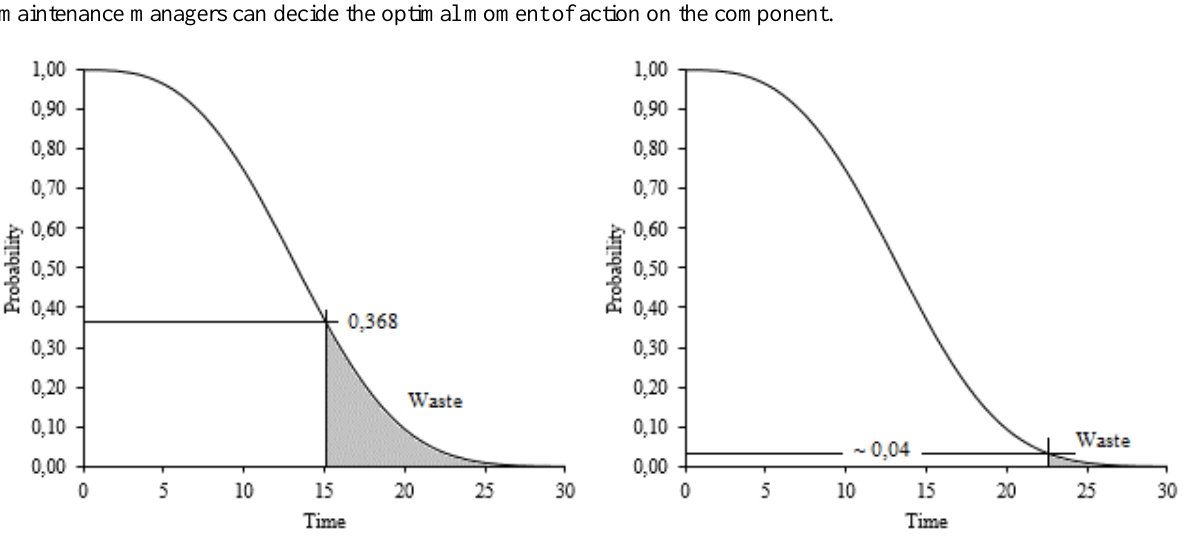
Figure 1. Reduction of waste due to change of maintenance